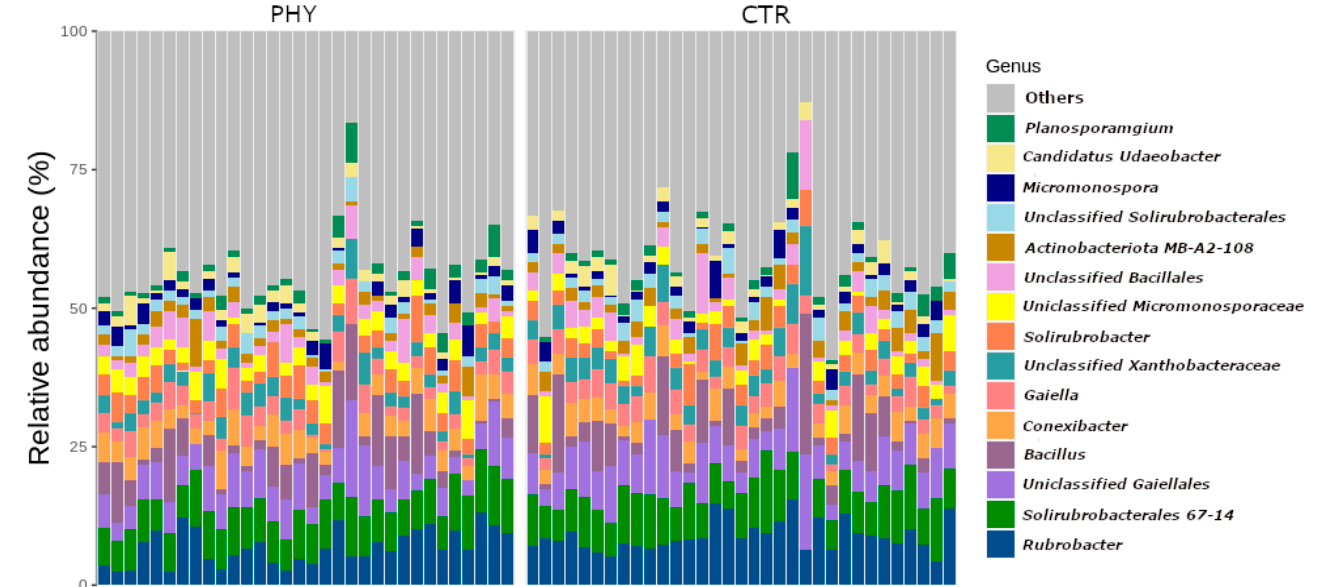
Figure 1. Relative abundance of top 15 genera from CTR and phytogenic liquid.